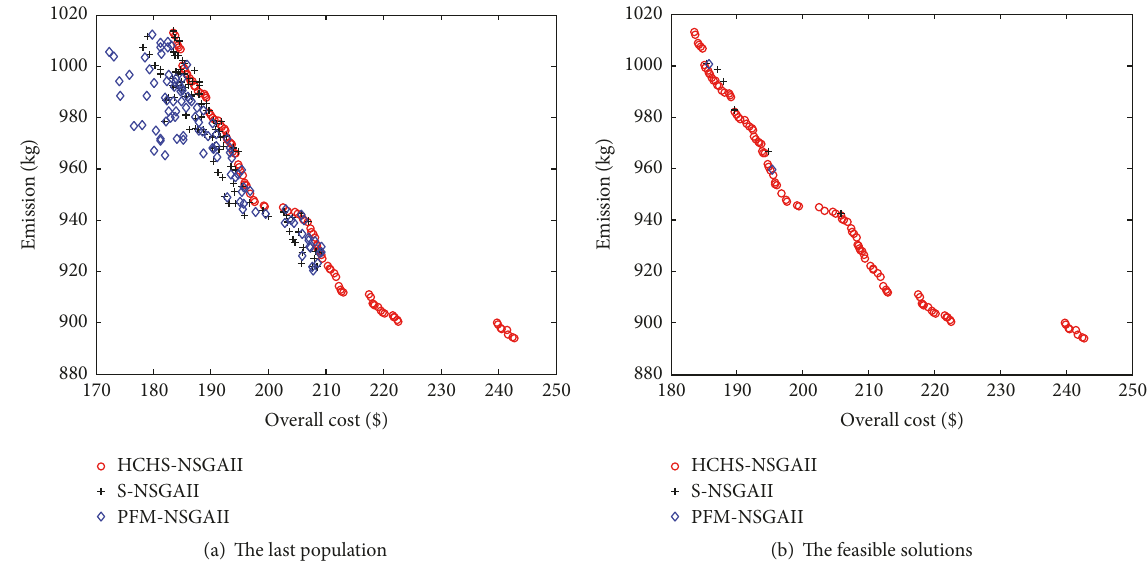
Figure 7: The best optimization results by HCHS-NSGAII, S-NSGAII, and PFM-NSGAII in Scenario Four.